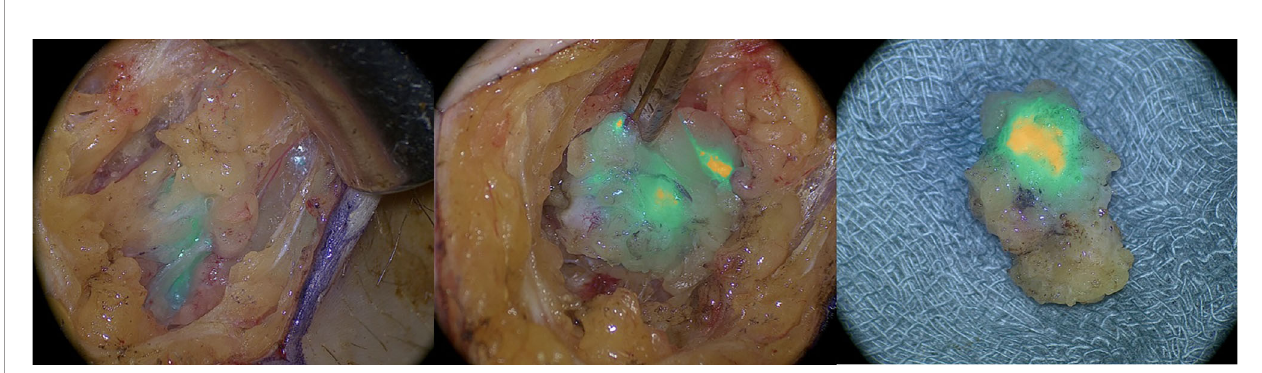
FIGURE 1 | Intraoperative imaging of indocyanine green positive lymphatic channels and inguinal sentinel lymph node with near infrared